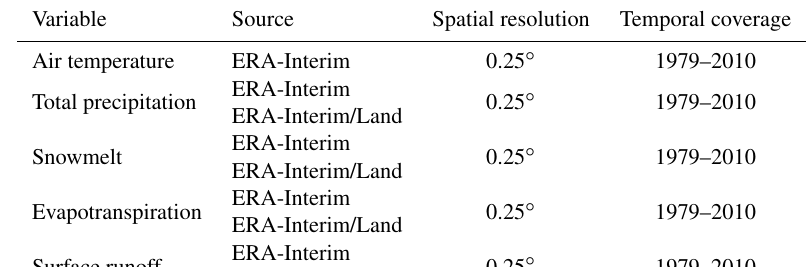
Table 1. The summary of the reanalysis data used in the study.